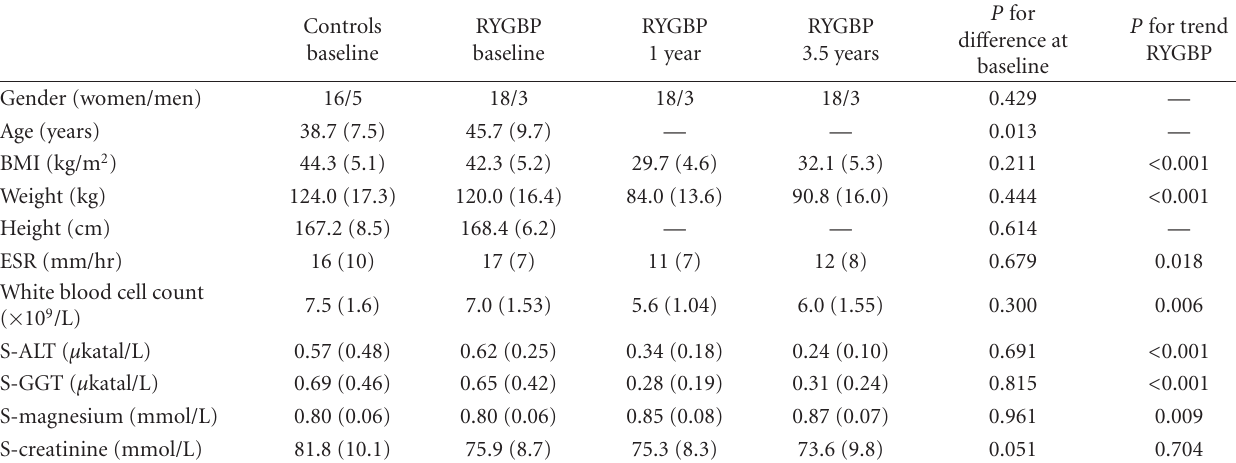
Table 1: Clinical characteristics for patients before RYGBP surgery and at followups 1 year and 3.5 years after surgery and for morbidly obese controls at